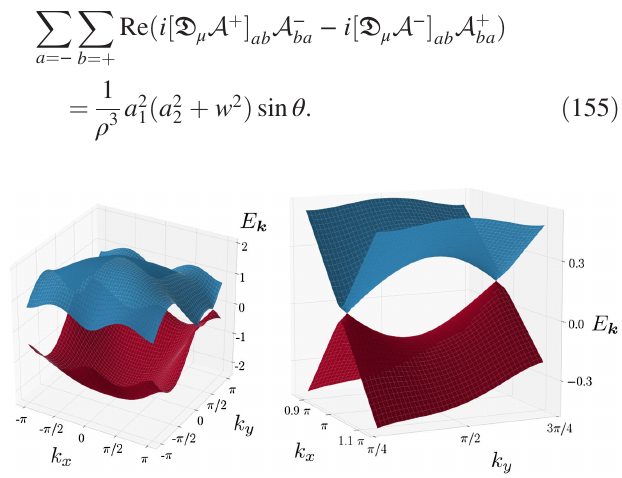
FIG. 3. Band structure of the Hamiltonian [Eq. (140) with Eq. (151)]. Left panel: dispersion over all the Brillouin zone. Right panel: enlarged view around the gapless Dirac